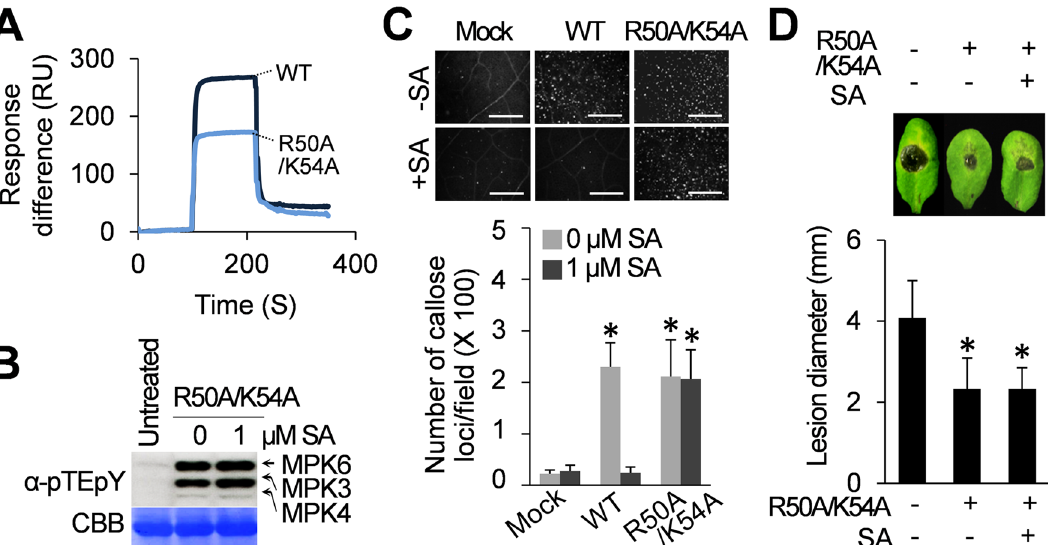
Fig 6. Arg50 and Lys54 are required for SA to bind and inhibit HMGB3 ’ s DAMP activity. A. Sensorgrams obtained with 1 μ M wild type (WT) HMGB3 and the R50A/K54A mutant using a 3AESA-immobilized sensor chip. The signals detected from a mock-coupled control chip were subtracted. B. The ability of the R50A/K54A mutant to activate MAPKs was not suppressed by SA. Leaves were sampled 15 min after infiltration with water containing 1 μ M R50A/ K54A with or without 1 μ M SA. Phosphorylated MPK3, MPK4, and MPK6 were detected by α -pTEpY antibody. Rubisco large subunit protein stained with CBB served as the loading control. C. R50A/K54A-induced callose deposition was not suppressed by SA. Leaves were sampled 15 h after infiltration with water containing 0.1 μ M HMGB3 (WT) or 0.1 μ M R50A/K54A with or without 1 μ M SA. Representative pictures for callose staining are shown in the upper panel. Bars = 100 μ m. Data are the mean ± SD (lower panel, n = 20). Leaves infiltrated with water served as mock control. Asterisks indicate a significant difference from the mock-treated leaves ( t test, P < 0.05). D. SA failed to inhibit the enhanced resistance to B . cinerea induced by mutant HMGB3 (R50A/ K54A). Leaves were infiltrated with water containing 0.1 μ M mutant HMGB3 with or without 1 μ M SA one day before B . cinerea infection. Representative disease symptoms at 3 dpi are shown in the upper panel. Data corresponding to this time point are presented as the mean ± SD (lower panel, n = 6). Asterisks indicate a significant difference from the mock-treated leaves ( t test, P < 0.05). Leaves infiltrated with water served as a